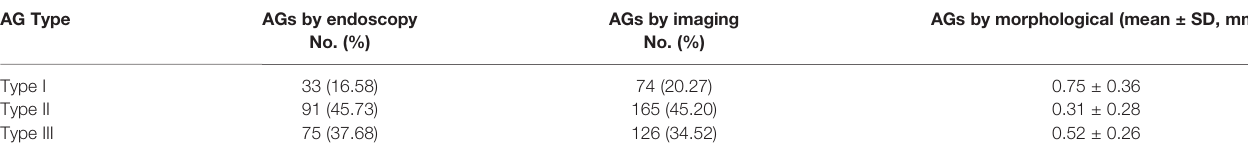
TABLE 2 | Type of AG in cadaveric specimens and 268 patients.